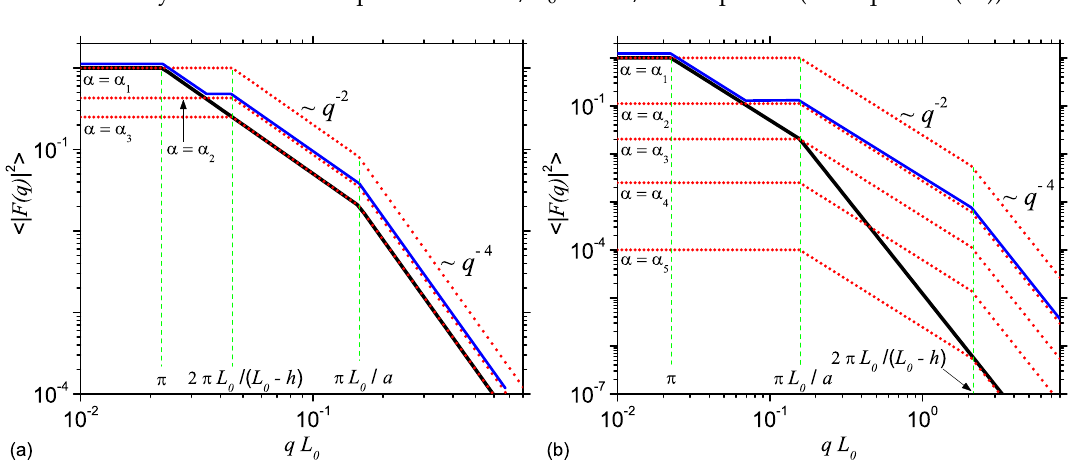
(or Figure 5b)—black curves. The scattering intensity gives a succession of the type q 0 → q − 2 → q − 4 power-law decays. The transition points are at π / L 0 and π / a as expected (see Equation (14)).